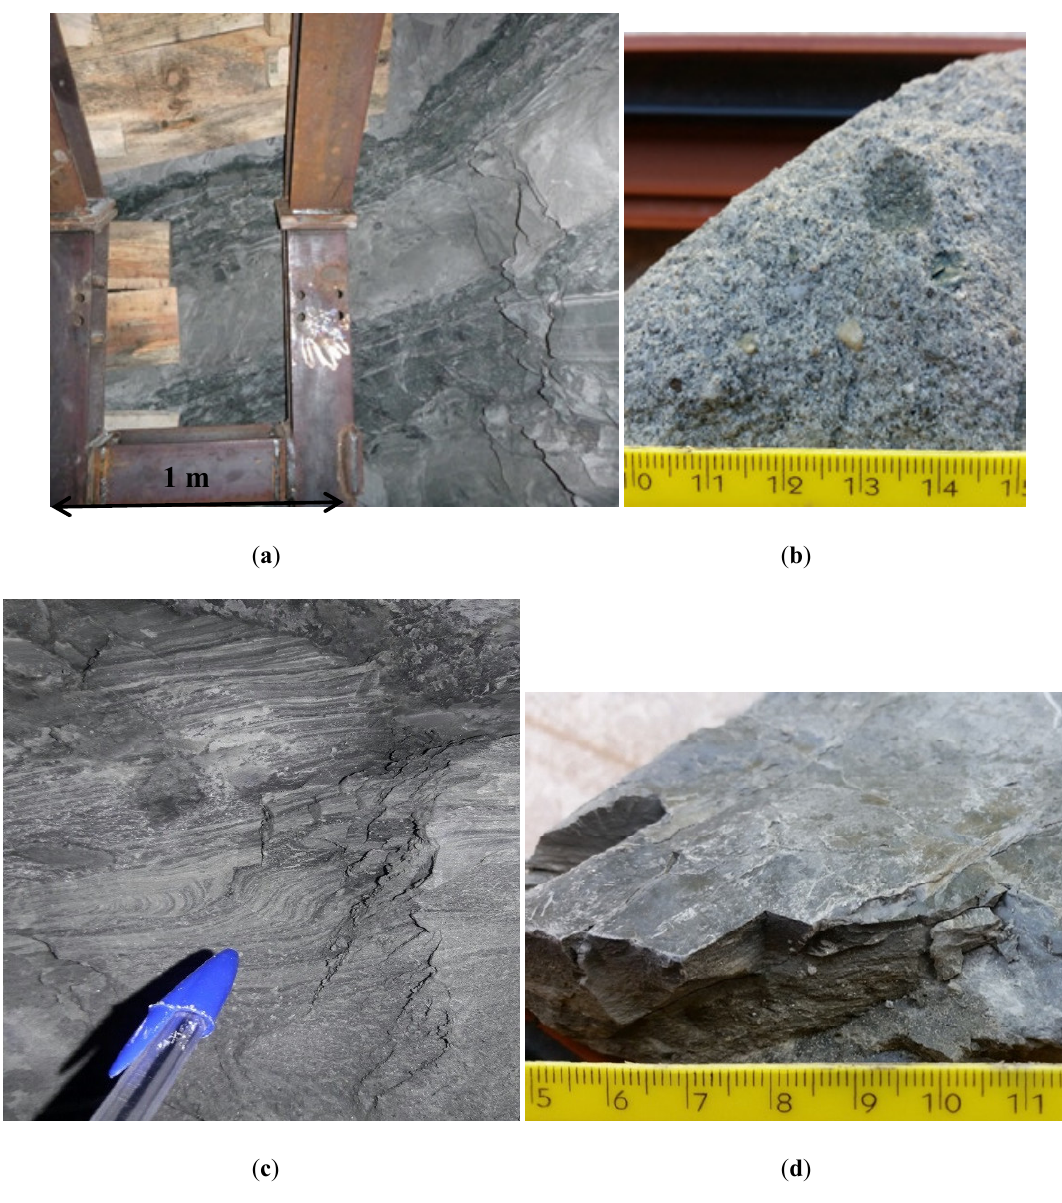
Figure 5. Arenaceous-pelitic stratigraphic sequences: ( a ) bedding; ( b ) coarse-grained arenite; ( c ) parallel and cross lamination in silty-arenaceous layers; ( d ) dark silty argillite.